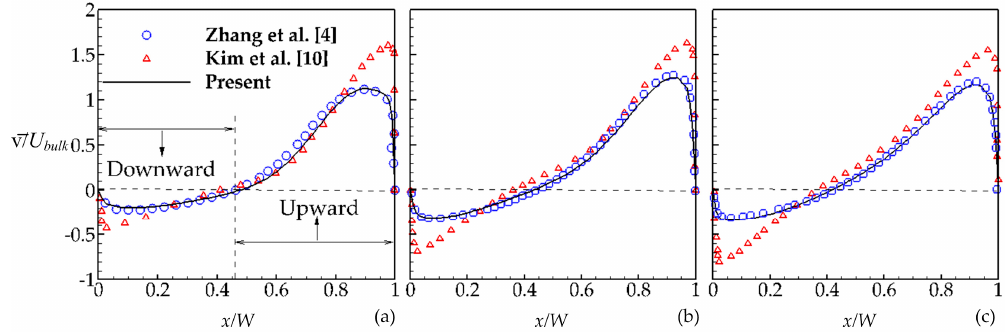
Figure 2. Distribution of vertical velocity component along x direction at different elevations: ( a ) y / H = 0.27; ( b ) y / H = 0.5; ( c ) y / H = 0.72.